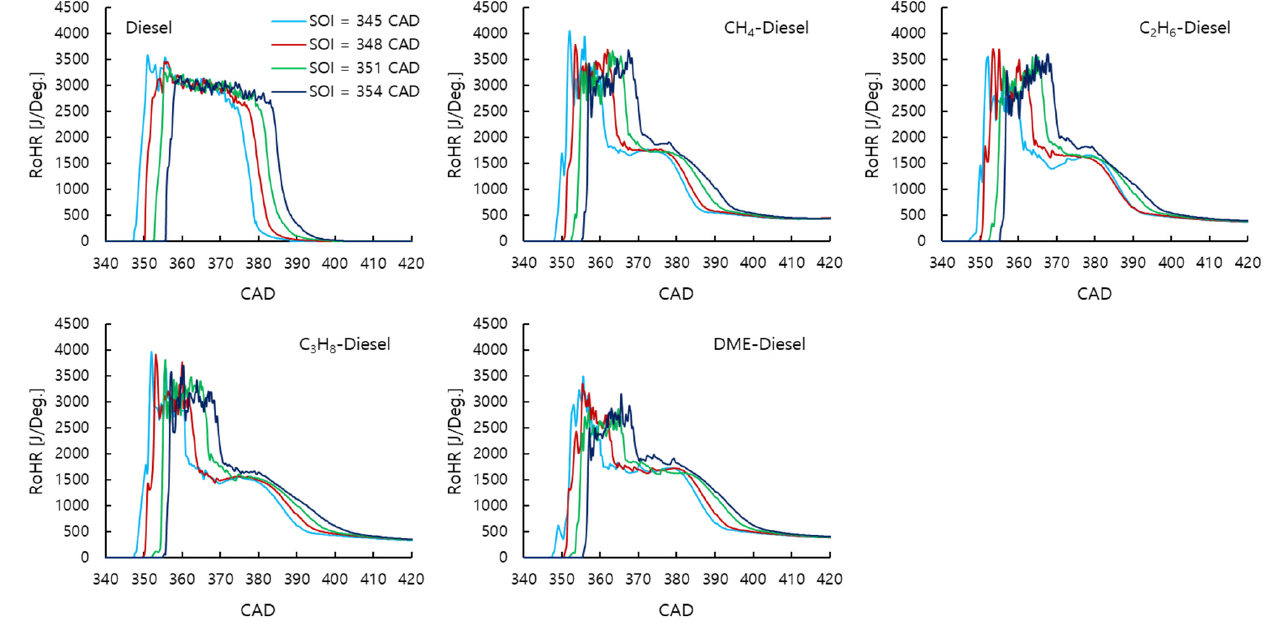
Figure 21. Rate of heat release diagrams according to pilot SOI angles in all combustion modes